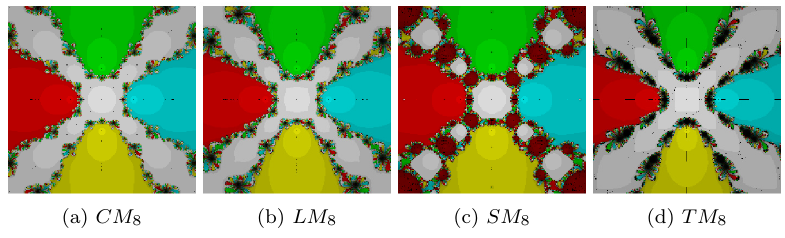
Figure 5. The methods for test problem